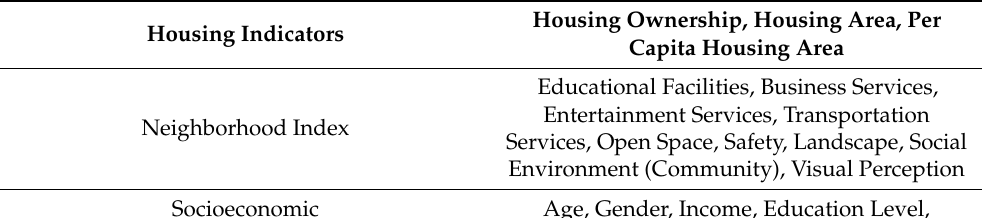
Table 1. Quality of life evaluation index for social sustainability in community regeneration.